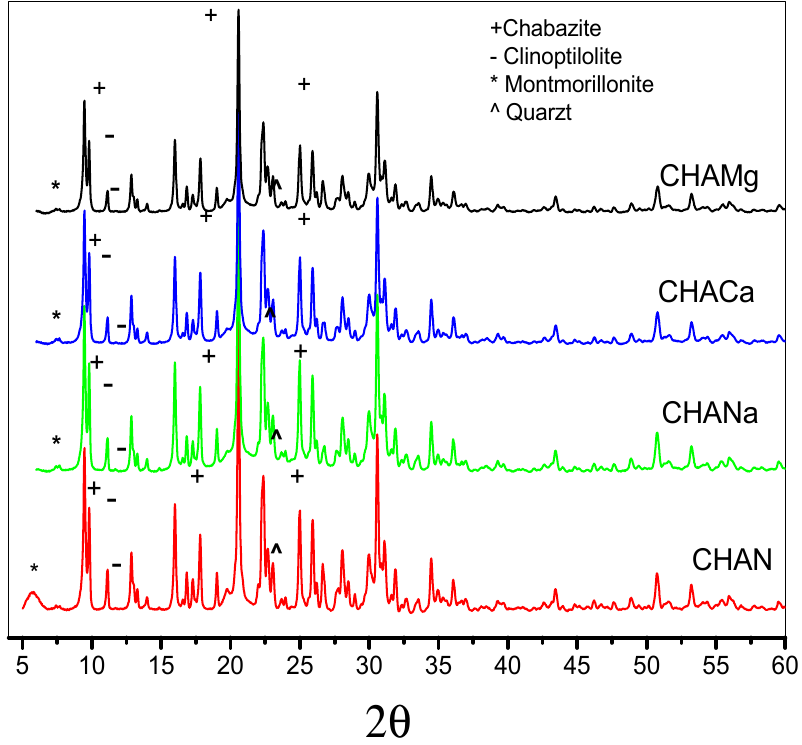
Figure 2. X − ray diffraction of natural (CHAN) and exchanged chabazite (CHANa, CHACa, and Figure 2. X-ray diffraction of natural (CHAN) and exchanged chabazite (CHANa, CHACa, and CHAMg), Rietveld refinement. CHAMg), Rietveld refinement. Table 2. Mineralogical phases of natural zeolite used in the study (wt%), XRD. Table 2. Mineralogical phases of natural zeolite used in the study (wt%), XRD. Mineralogical Phases Mineralogical